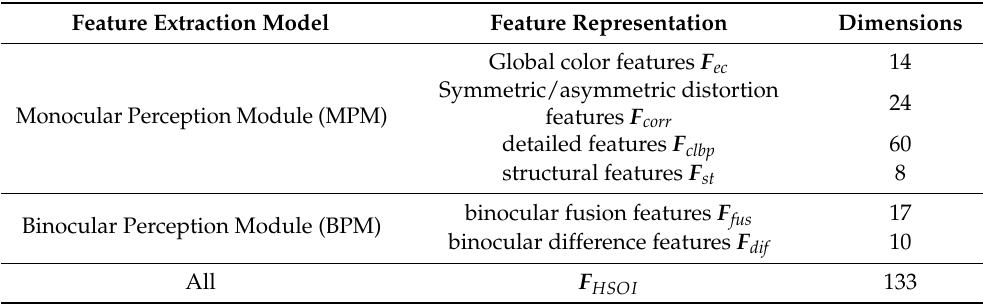
Table 4. The features extracted in the proposed